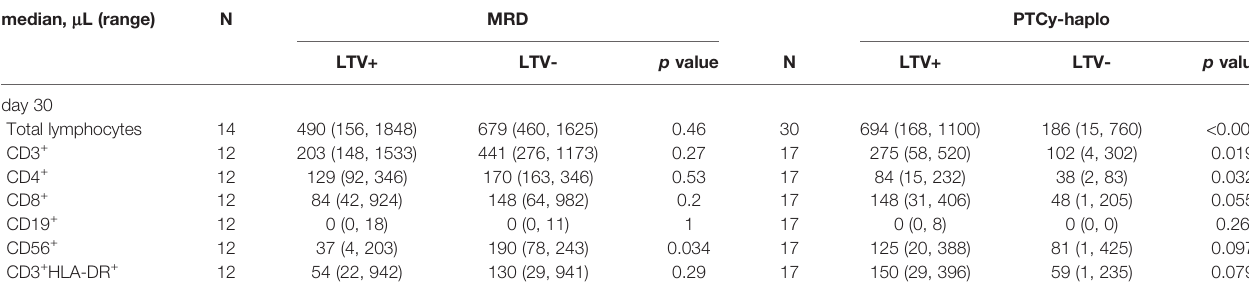
TABLE 2 | Lymphocytes count in MRD and PTCy-haplo. median, m L (range)